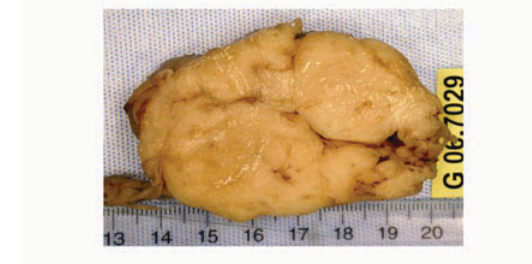
Figure 2. Hematoxylin-phloxine-saffron staining. Intramyomic lymphoid infiltration (a) (original magnification x 100). Lymphocytic concentration around a blood vessel and a lymph follicle formation (arrow) (b) (original magnification x